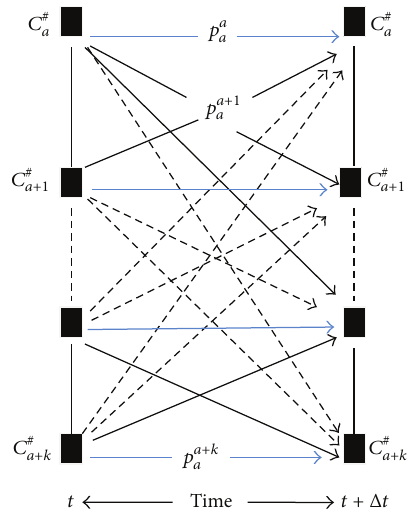
Figure 3: Occupancy transition in a session.